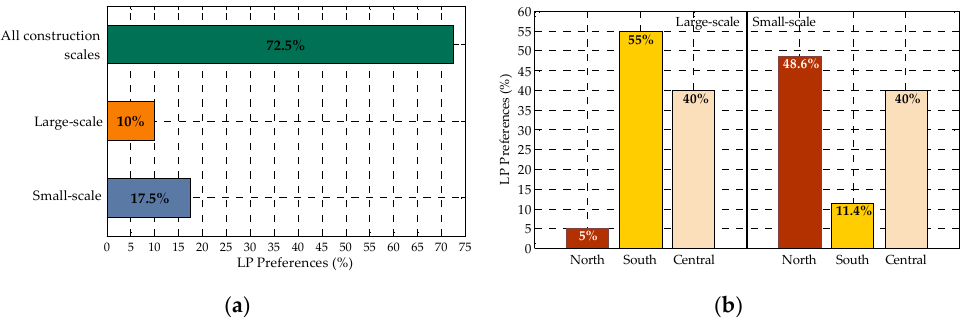
Figure 8. Local Public (LP) preferences (%) on Photovoltaic (PV) projects: ( a ) per construction scale and ( b ) per both construction scale and geographic segment.